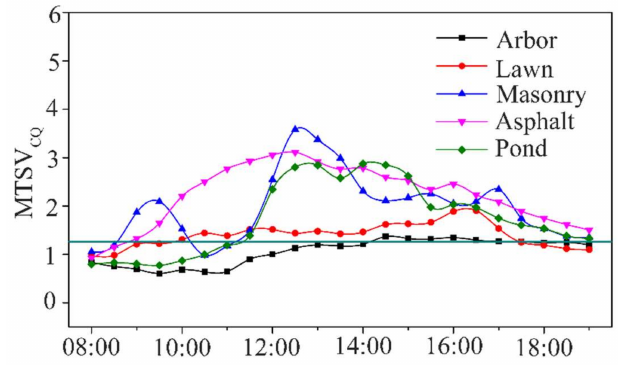
Figure 9. The MTSV CQ of five different zones.